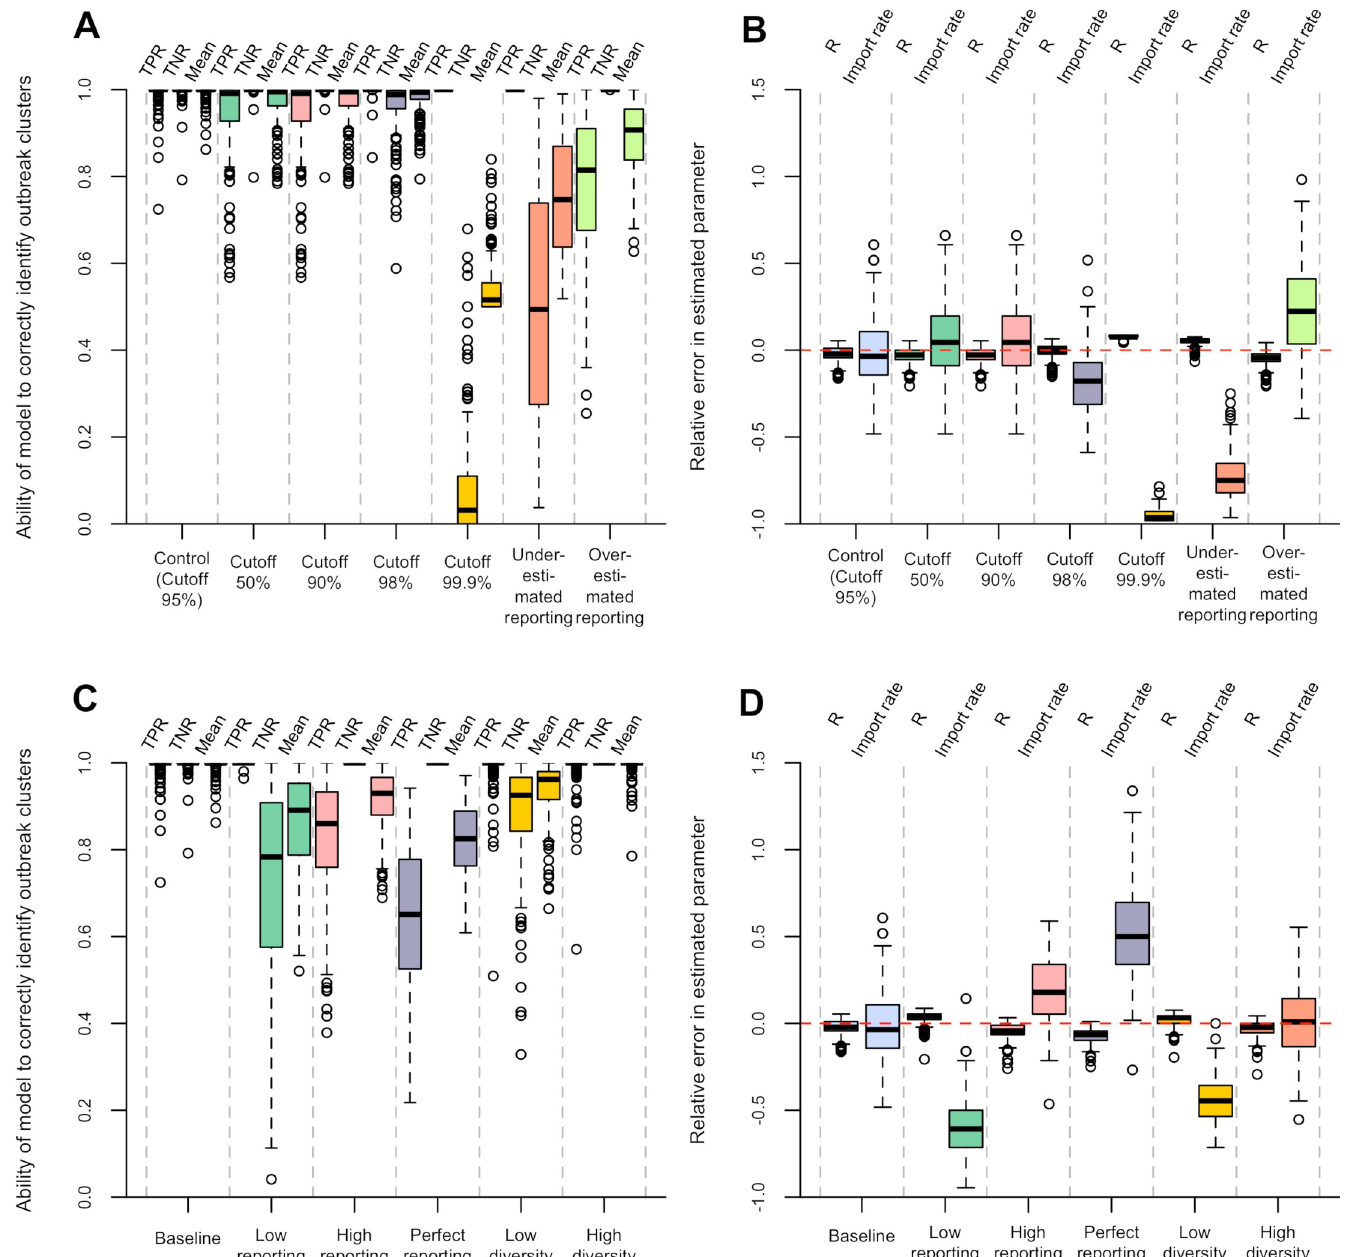
Fig 5. Summary of the simulation study. A, B : For the baseline simulation (mimicking rabies transmission in Bangui), performance of the method using different reconstruction scenarios, varying in terms of cutoff used at the pruning step and assumed reporting rate. C, D : Performance of the method, using the control reconstruction scenario (i.e. assuming transmission and evolution parameters as well as reporting rate are known), applied to different simulation scenarios varying in terms of reporting rate and diversity of the pathogen in the imported cases. See materials and methods and S1 Text for definition of all the simulation and reconstruction scenarios. Panels A and C show, across these scenarios, the ability of the model to correctly identify outbreak clusters, as measured by the true positive rate ( TPR , proportion of pairs of cases belonging to the same transmission tree who are inferred to be in the same outbreak cluster), the true negative rate ( TNR , proportion of pairs of cases not belonging to the same transmission tree who are assigned to different outbreak clusters), and the mean between TPR and TNR . Panels A and C show, across all scenarios, the distribution of the relative error in the estimated reproduction number ( R ) and importation rate.